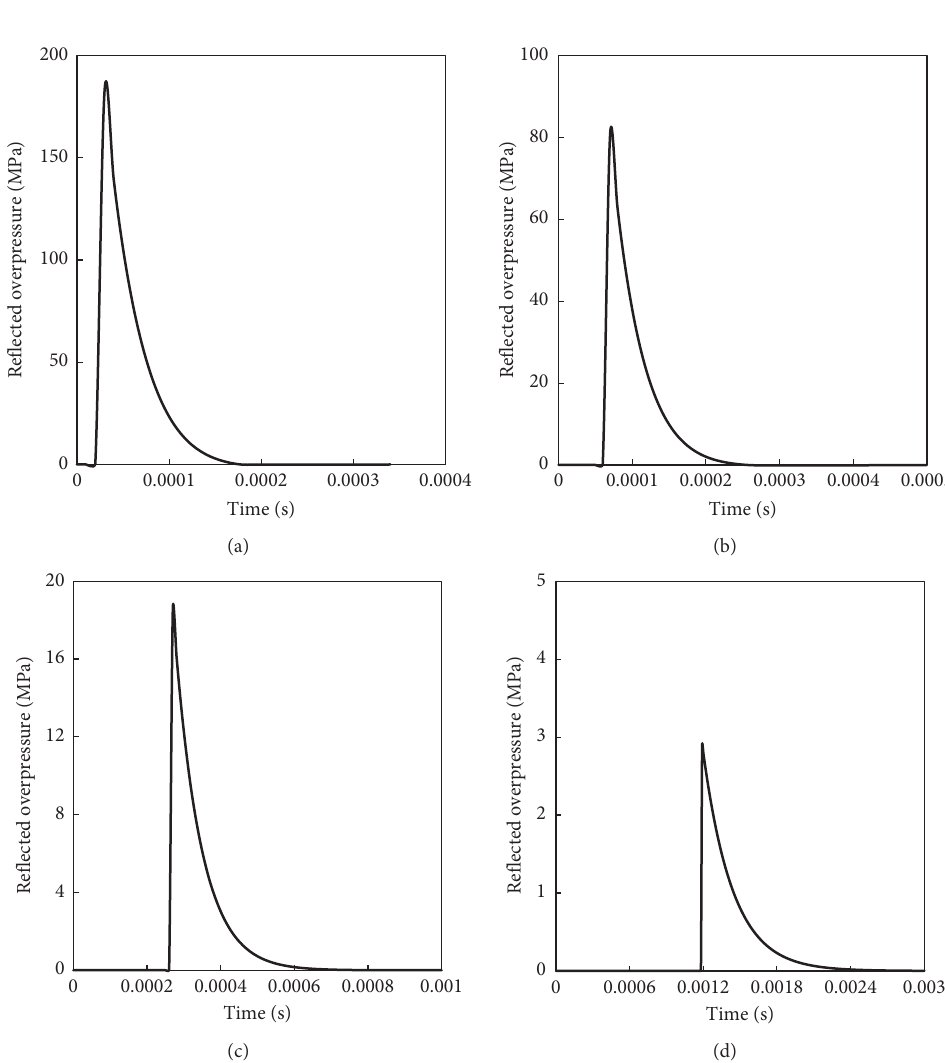
Figure 2: Blast pressure history curves for the scaled distance equal to (a) 0.15m/kg 1/3 , (b) 0.30m/kg 1/3 , (c) 0.60m/kg 1/3 and (d) 1.20m/kg 1/3 , respectively.